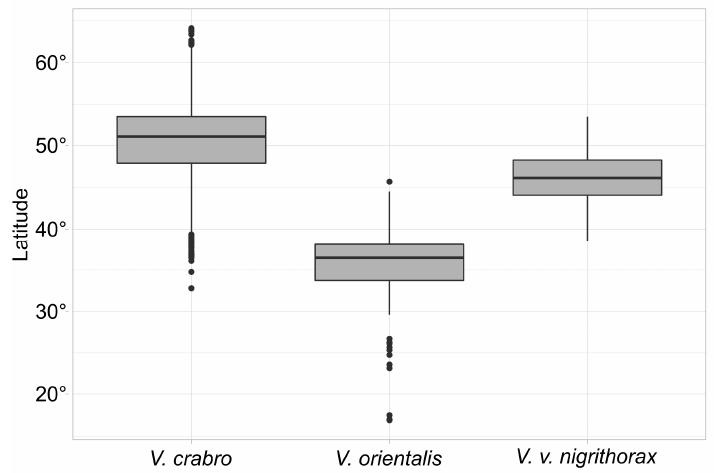
Figure 3. Distribution of Vespa crabro , V. orientalis and V. v. nigrithorax records along the latitudinal gradient of the study area, after considering the sampling bias.